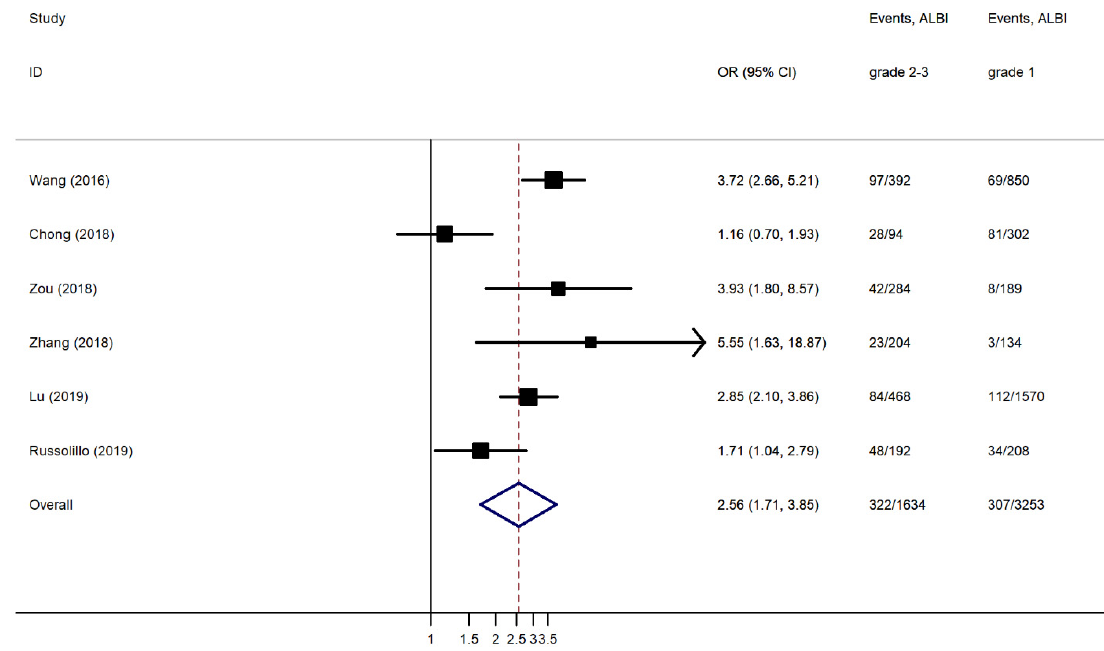
Figure 4. Forest plot of the pooled Odds Ratio (OR) for post-hepatectomy liver failure (PHLF) in ALBI grades 2 and 3 compared to ALBI grade 1 after removing one study that included a small subgroup of patients other than HCC. Events: PHLF/No PHLF; and CI: Confidence Interval.